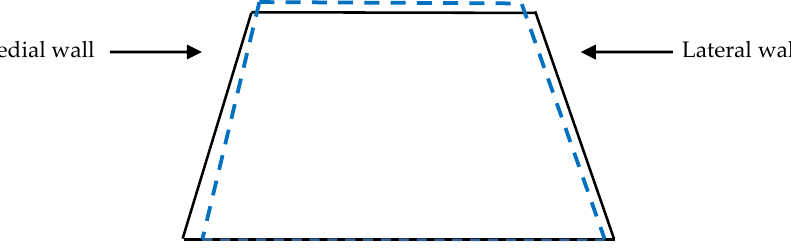
Figure 2. Pre-trimming (solid black line) and post trimming (blue dotted line); note the more upright angle of the medial wall, acutely angled lateral wall, and increased wall lengths.